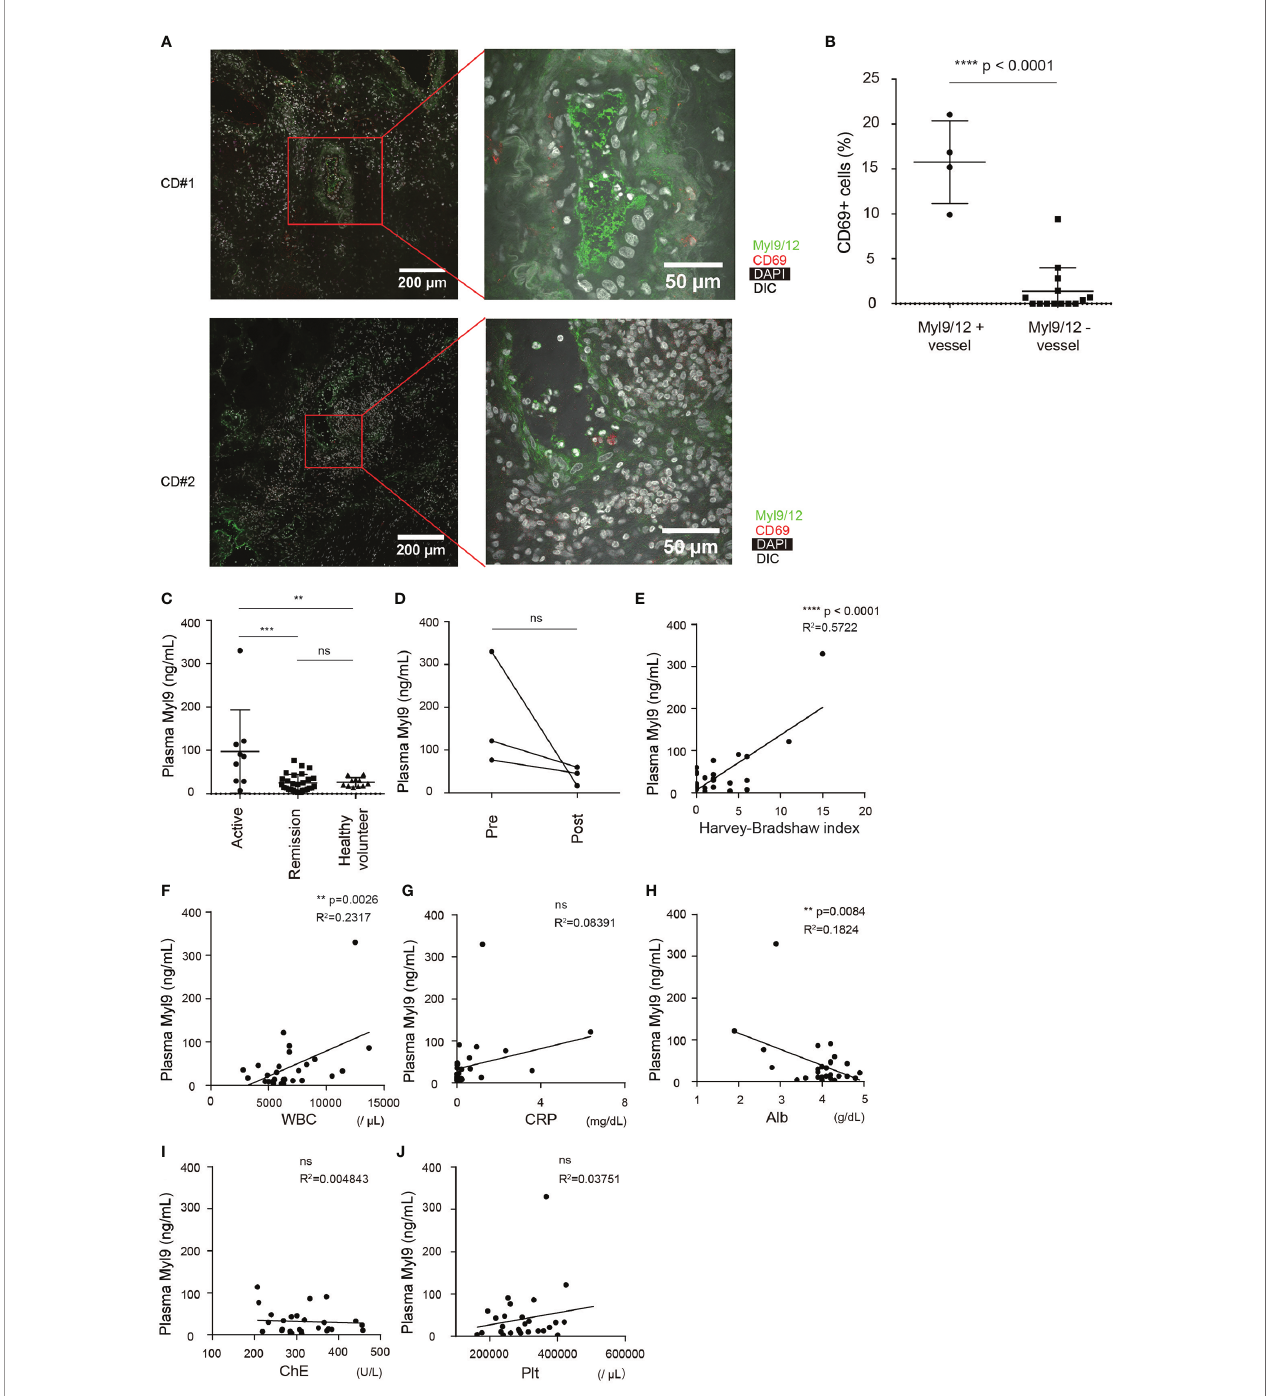
FIGURE 5 | The Myl9/12 expression in CD patients. (A) Immunohistological analyses of in fl amed gut specimens from CD patients, stained as indicated (n = 3). Red squares indicate blood vessels, which are identi fi ed based on the DIC image (×400). (B) The frequency of CD69-expressing cells close to Myl9/12-positive vessels versus Myl9/12- negative vessels in the in fl amed gut. A total of 4 fi elds where Myl9/12-postive vessels were located in the center and 14 fi elds where Myl9/12-negative vessels were located in the center were examined in gut samples from three patients. (C) Plasma Myl9 levels from CD patients with active CD (HBI ≥ 5) or CD patients who were in remission (HBI <5) and healthy volunteers (active CD, n = 9, remission CD, n = 28, healthy volunteers, n = 11). **p < 0.01; ***p < 0.001; ****p < 0.001. (D) The plasma Myl9 levels in the patients before (pre) and after (post) treatment. The Myl9 levels from the same patients are connected. (E – J) Correlations of the plasma Myl9 level with the HBI (E) , WBC count (F) , CRP (G) , serum Alb (H) , serum cholinesterase (I) , and platelet count (J) . ns, not signi fi